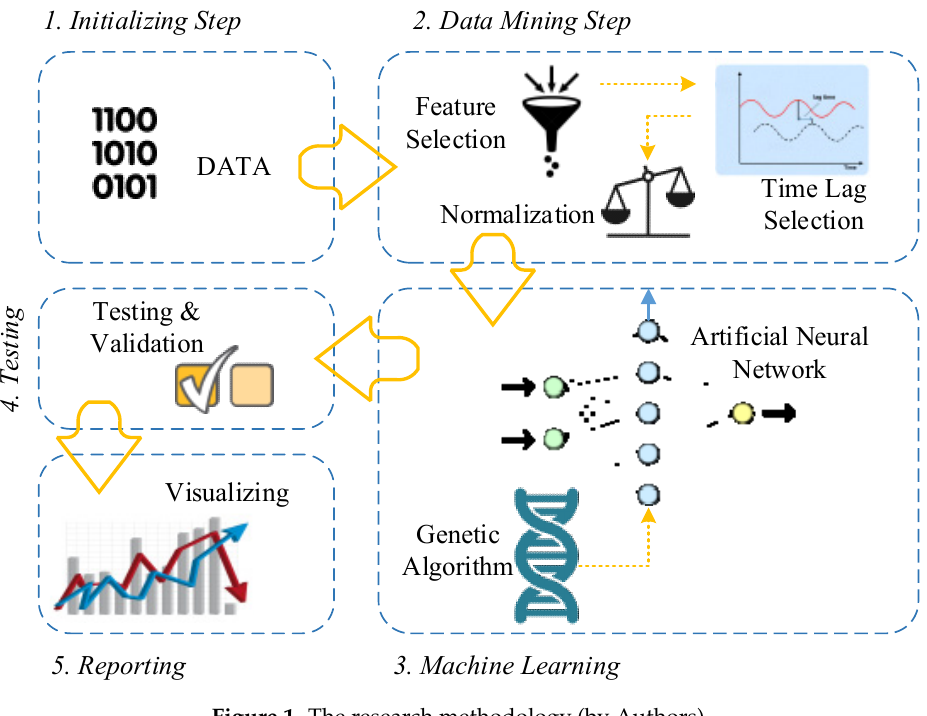
Figure 1. The research methodology (by Authors).